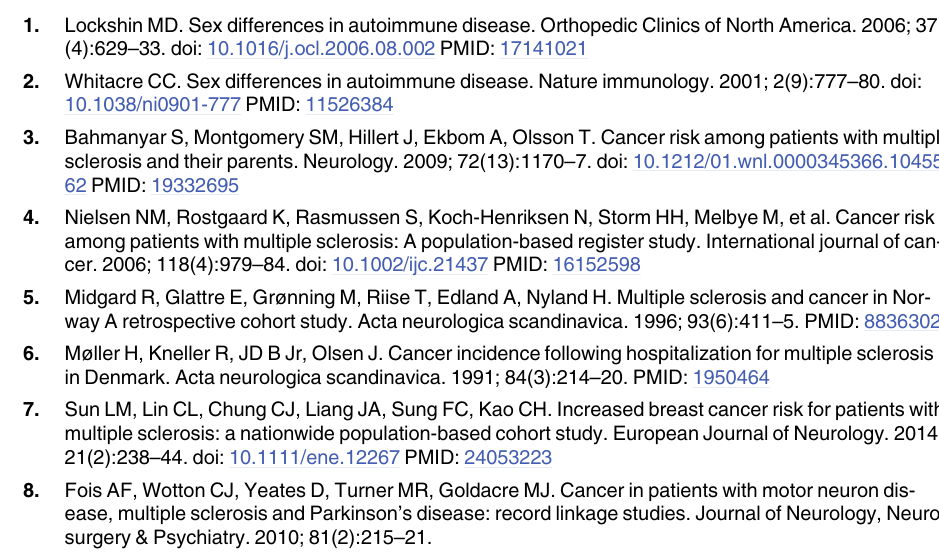
S11 Table. Incidence rate, Hazard ratios (HR) and 95% confidence intervals (CI) for associ- ation between MS (Those patients who had two codes of MS) and breast cancer, stratified by menopausal